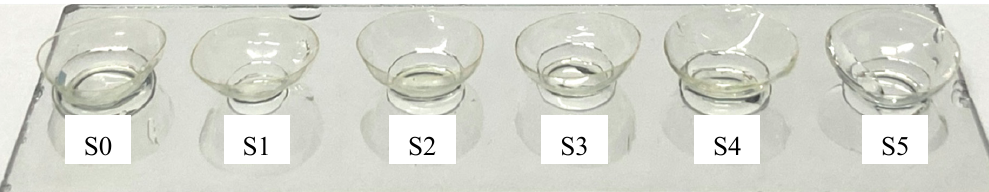
Figure 5. Photos of SNPs hydrated contact lenses.